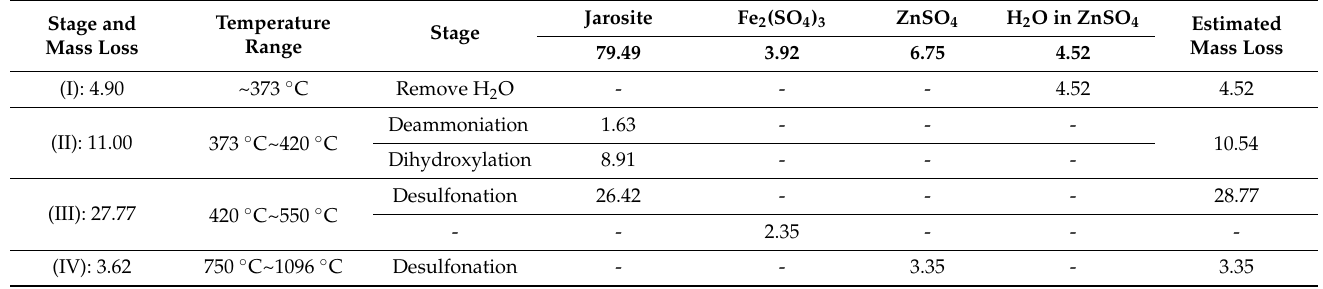
Table 5. Estimated mass loss (mass%) of escaped constitutes from jarosite residue